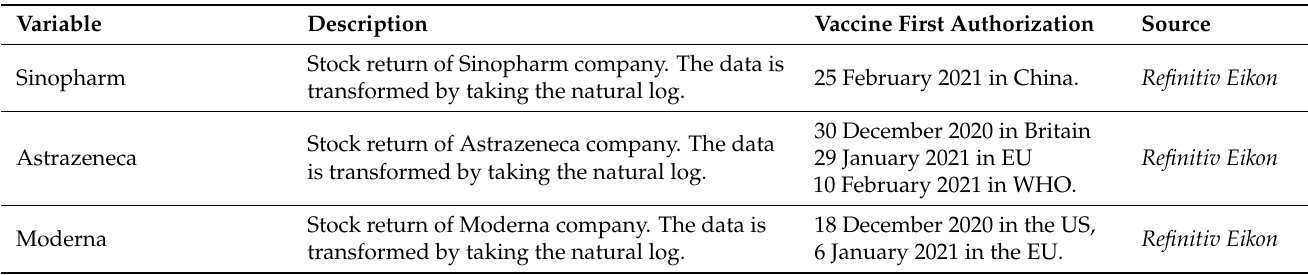
Table 1. Description of